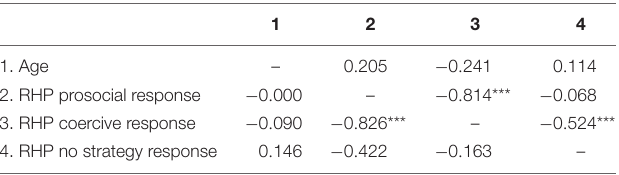
TABLE 2 | Correlations between variables for boys (above diagonal) and girls (below diagonal) with verbal ability partialled